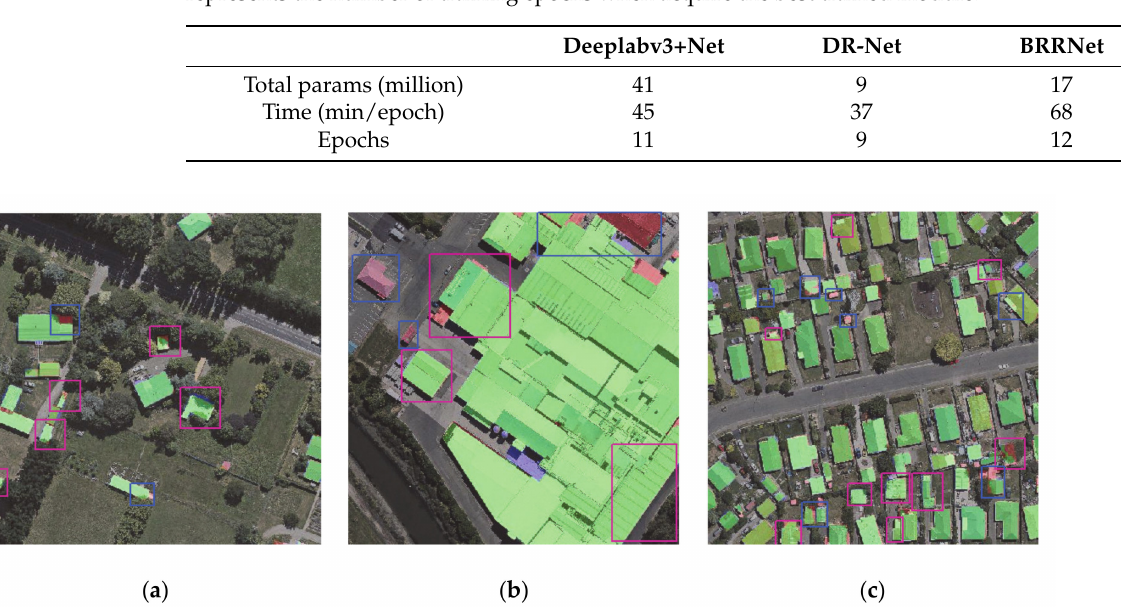
Figure 6. The effects of DR-Net and the batch size was set to 2. ( a – c ) show the performance of DR-Net. Pink boxes annotate the best performance area compared with other three methods whose performance is shown in Table 2 and Figure